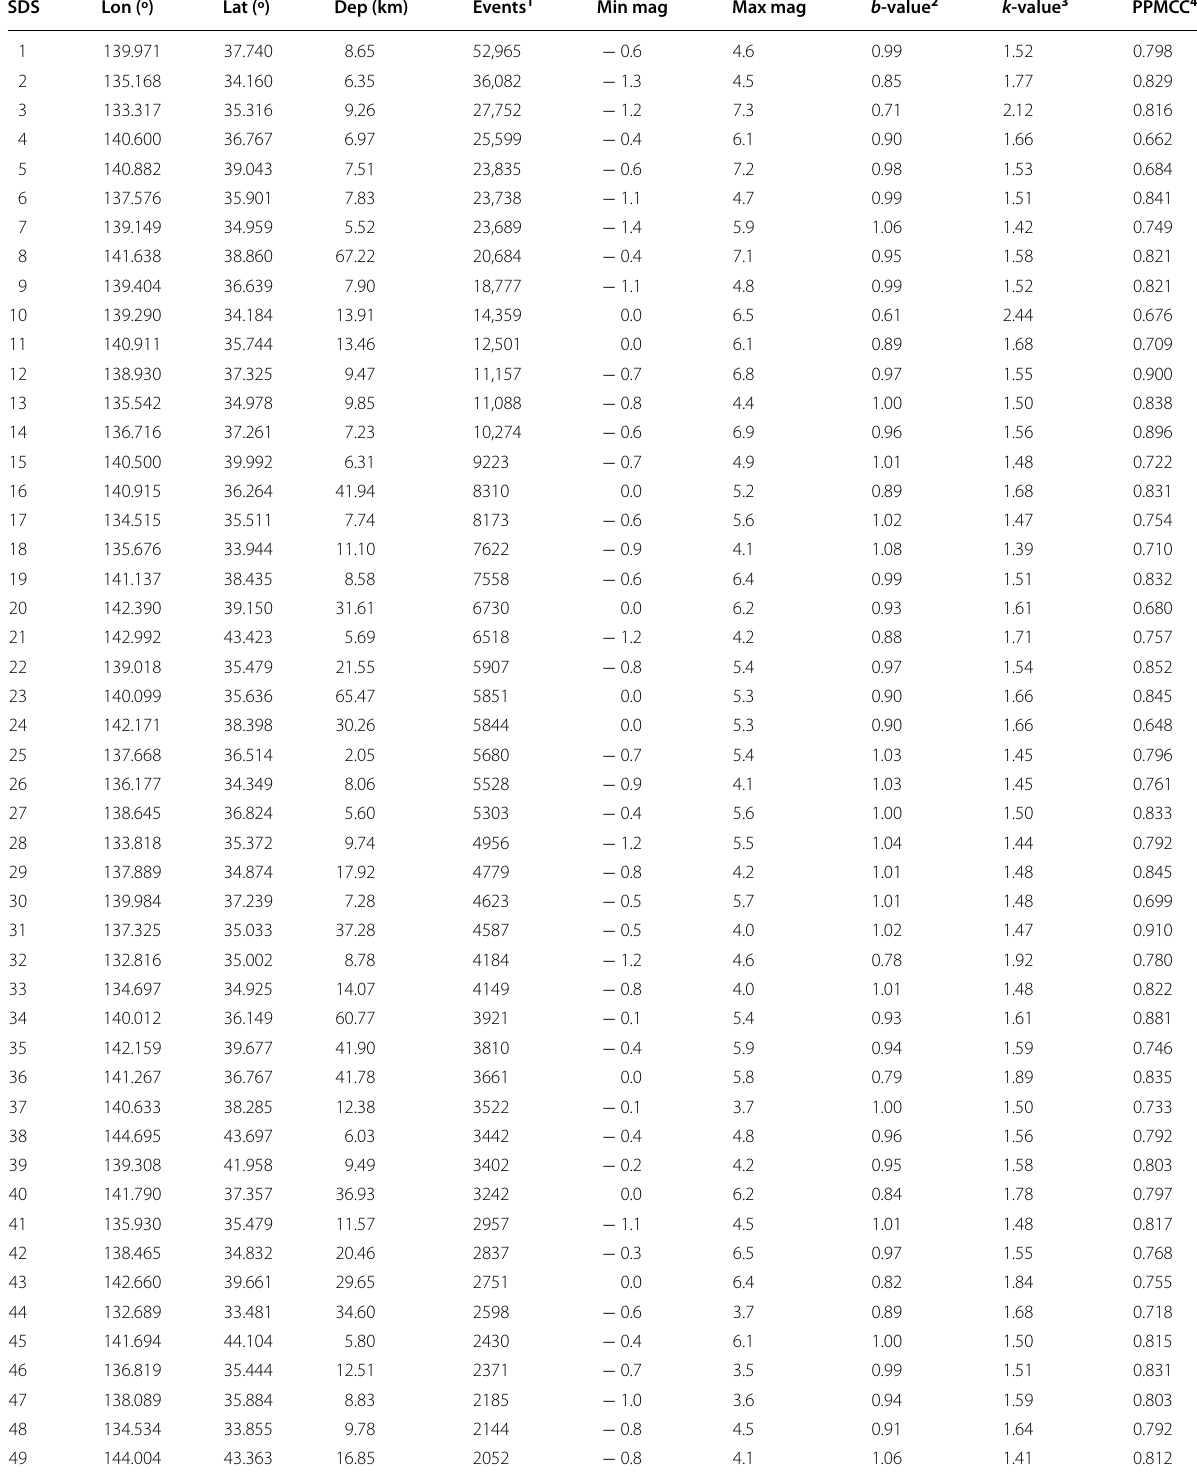
Table 1 Parameters and results of the seismically dense spheres (SDS) in this